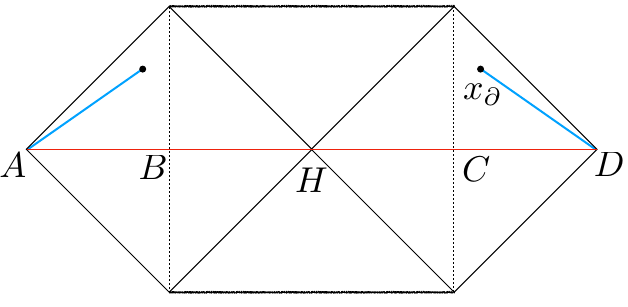
Figure 4: Shown here is a two-sided 4d black hole (with two of the spatial dimen- sions suppressed) coupled to two baths. See also figure 2. We want to compute the entanglement entropy of the union of the two blue regions shown. This diagram lives on the boundary of a static 5d spacetime whose exterior region was computed numerically in section